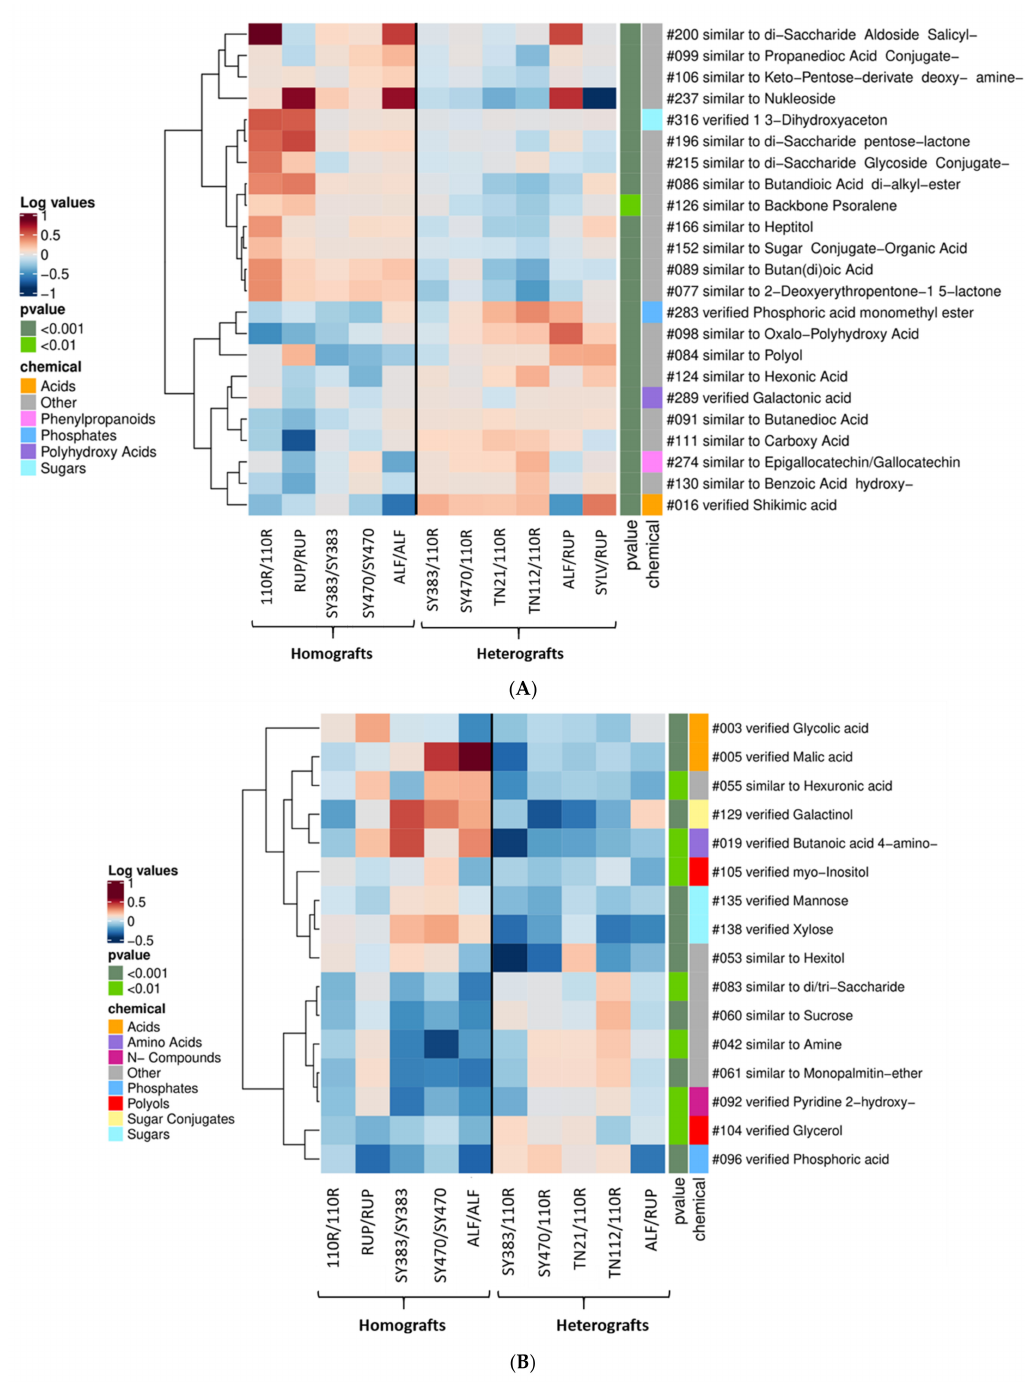
Figure 1. Heat map clustering analysis of homografts versus heterografts at 5–6 months after grafting: ( A ) In the leaves ; ( B ) and the rootstock phloem exudate ’ datasets. Leaves and phloem rootstocks’ metabolites found to be increased or decreased in at least 80% of the homograft combinations and less than 20% of the heterografts (i.e., n = 23 and 16, respectively). Selected metabolites were retrieved from all metabolites found significantly different in at least one of the leaves and phloem rootstock paired-comparison of a homograft versus a heterograft at p < 0.05 according to the Tukey post hoc test (i.e., n = 231 and 30, respectively). Mean log 10 -transformed values per graft combination are plotted, as well as the p -value range (<0.01 and <0.001) and the potential chemical class (“chemical”) of plotted metabolites. Not-verified metabolites (named with the prefix “similar to”) were included in the chemical class assigned as “Other”. Cluster analysis of metabolites was performed using the Pearson correlation